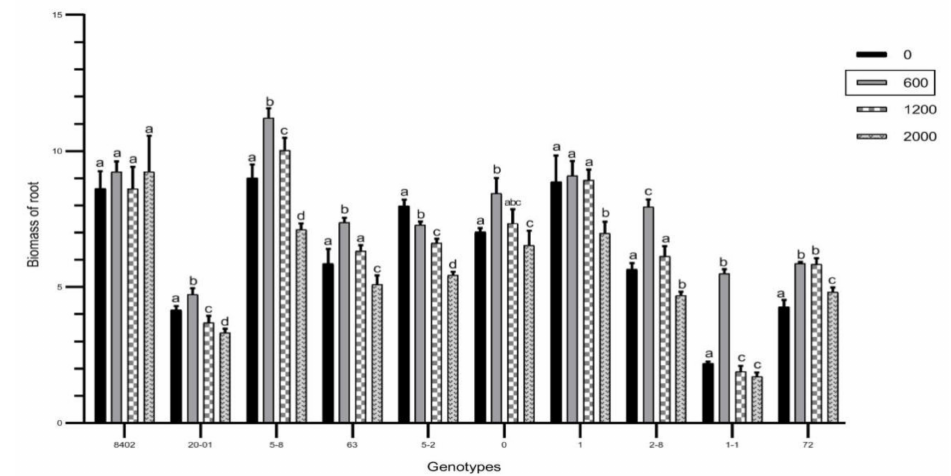
Figure 3. Effects of Sb concentration on the biomass of